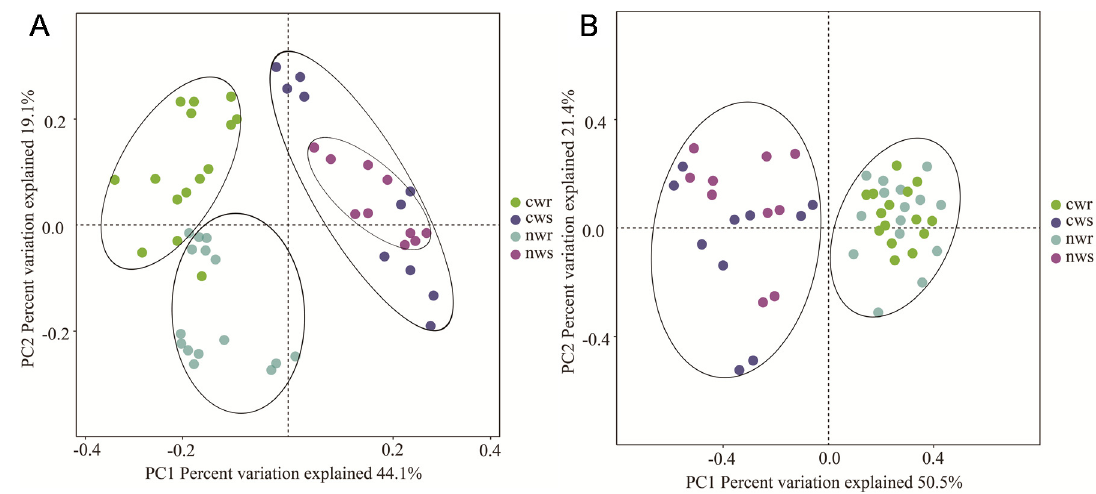
Figure 4. Principal coordinate analysis plot of the ( A ) bacterial and ( B ) fungal communities found in the rhizosphere and root endosphere of naturally grown and cultivated walnut trees. Principal components analysis (PCoA) plot of the first two principal components based on operational taxonomic units (OTUs) in the rhizosphere and root endosphere of walnut when exposed to naturally grown and cultivated walnut trees. 95% confidence ellipses (the ANOSIM test) were shown around the samples